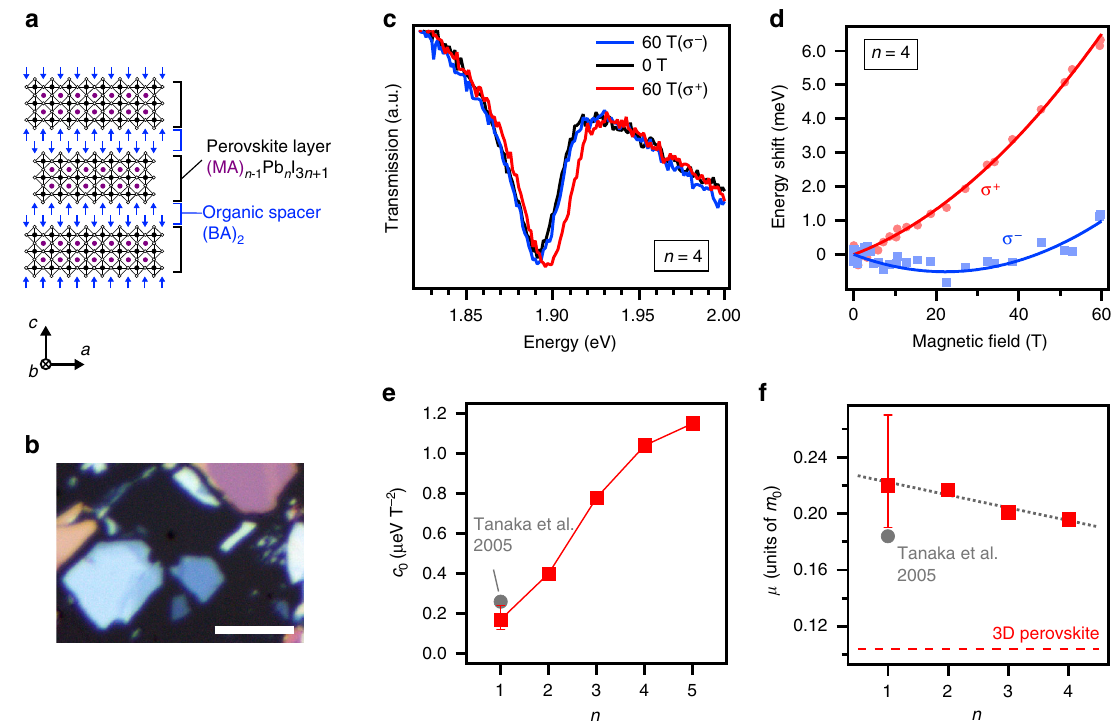
Fig. 1 Exciton reduced mass from magneto-absorption spectroscopy and theory. a Schematic of the RPP structure cut along the direction ĉ of stacking of the 2D layers. b Image of mechanically exfoliated RPP crystals. Scale bar is 10 µ m. c Magnetic fi eld dependence of the light transmission of an individual RPP with n equals to 4 crystal for right- ( σ ‒ ) and left-handed ( σ + ) circular polarization. d Corresponding shift of the exciton energy as a function of the magnetic fi eld. Fit of the data using Δ E = ±1/2 g 0 μ B B + c 0 B 2 yields c 0 = 1.04 ± 0.16 µ eV T − 2 and g 0 = 1.59 ± 0.03. e Derived diamagnetic shift coef fi cient of the measured RPPs (red squares). The value from Tanaka et al. 15 is also reported for RPPs with n equals to 1 with a slightly larger organic spacer. f Exciton reduced mass derived from fi tting the diamagnetic shifts with our theoretical model. The gray dotted line is a guide for the eyes. The red dashed line indicates average value of exciton reduced mass for the 3D perovskite MAPbI 3 . Error bars correspond to s.d. from the fi t of the shift of the exciton energy as a function of the magnetic fi